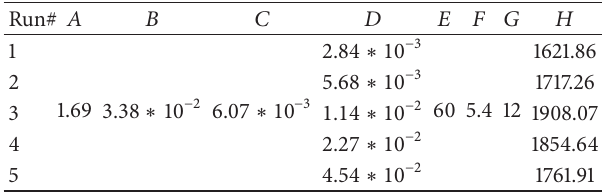
Table 5: Reactions conditions with different cross-linker concentra- tions.